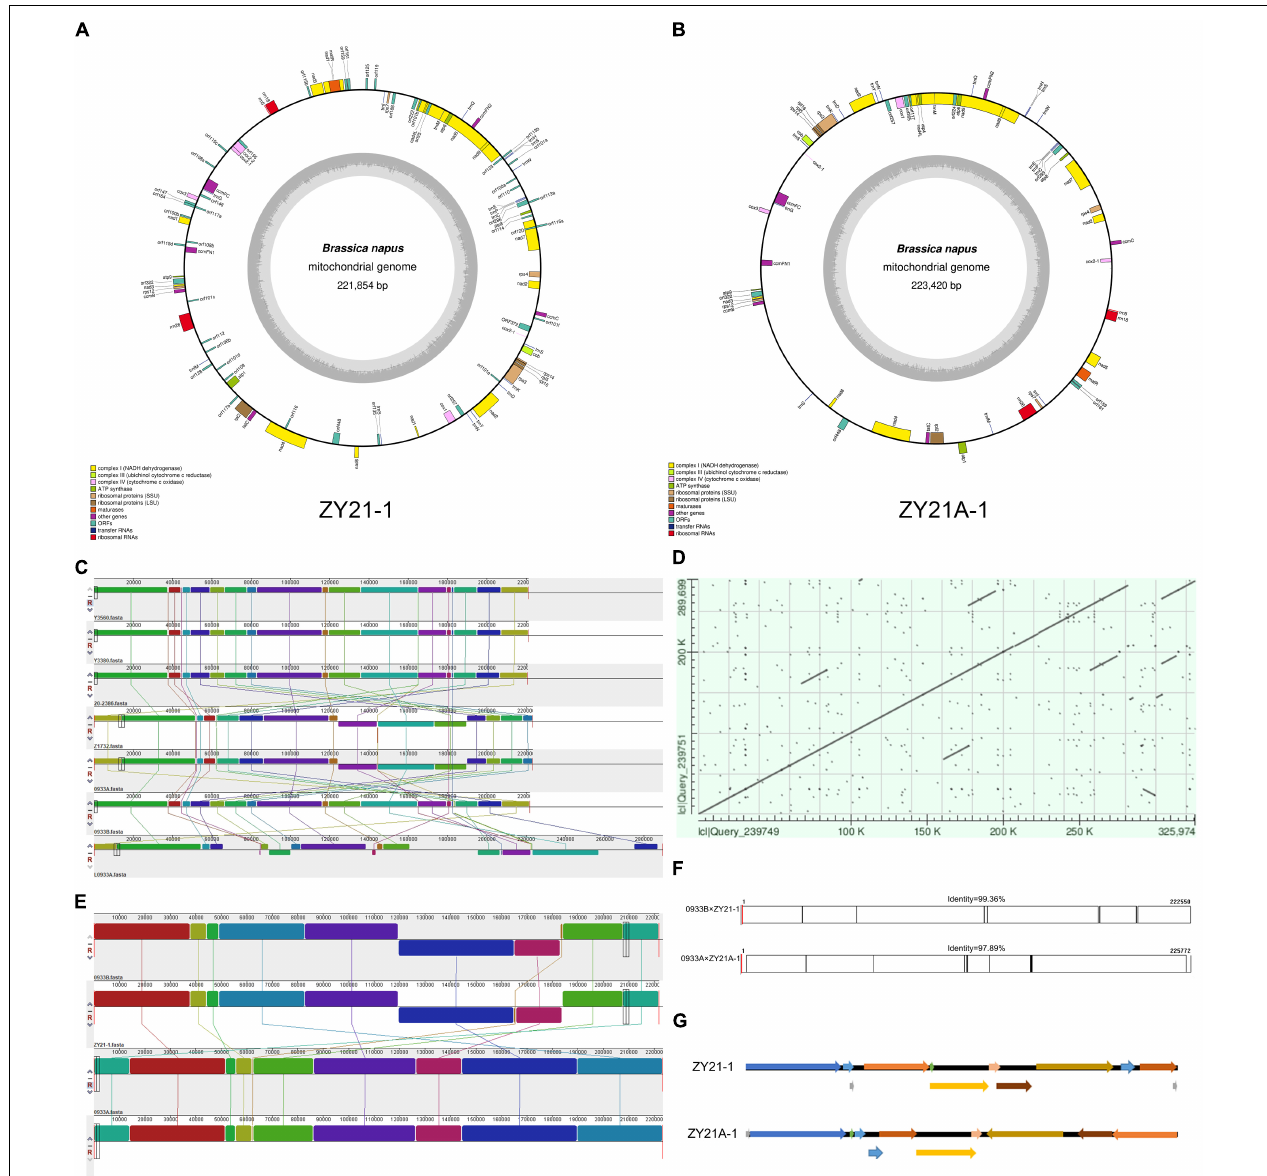
FIGURE 1 | Results of mitochondrial genome co-linearity analysis for different samples. (A) Annotated map of the mitochondrial genome of induced F 1 generation fertile progeny ZY21-1. (B) Annotated map of the mitochondrial genome of induced F 1 generation sterile progeny ZY21A-1. (C) Schematic diagram of mitochondrial genome co-linearity between parental and hybrid F 1 generation before and after induction, from top to bottom, Y3560, Y3380, 20-2386, Z1732, 0933A, 0933B, L0933A. (D) Comparison of the mitochondrial genome between hybrid hexaploid ZY26A-1 and its female parent L0933A. (E) Schematic diagram of mitochondrial genomic covariance between induced F 1 generation and 0933A and 0933B, from top to bottom, 0933B, ZY21-1, 0933A, ZY21A-1. (F) Comparison of mitochondrial sequences between 0933B and ZY21-1; comparison of mitochondrial sequences between 0933A and ZY21-1. (G) Comparison of mitochondrial genome arrangement of different fertile single plants in the induced F 1 generation ZY21-1and